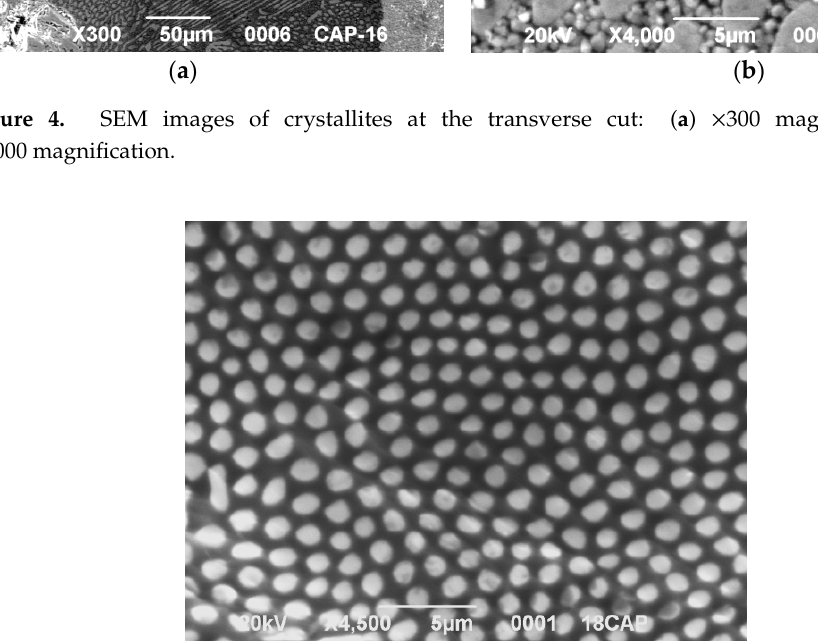
Figure 5. SEM image (magnification ×4500) of the eutectic structure at the surface of CeAlO 3 crystal annealed at 1700 °C under vacuum in contact with Al 2 O 3 crystal.